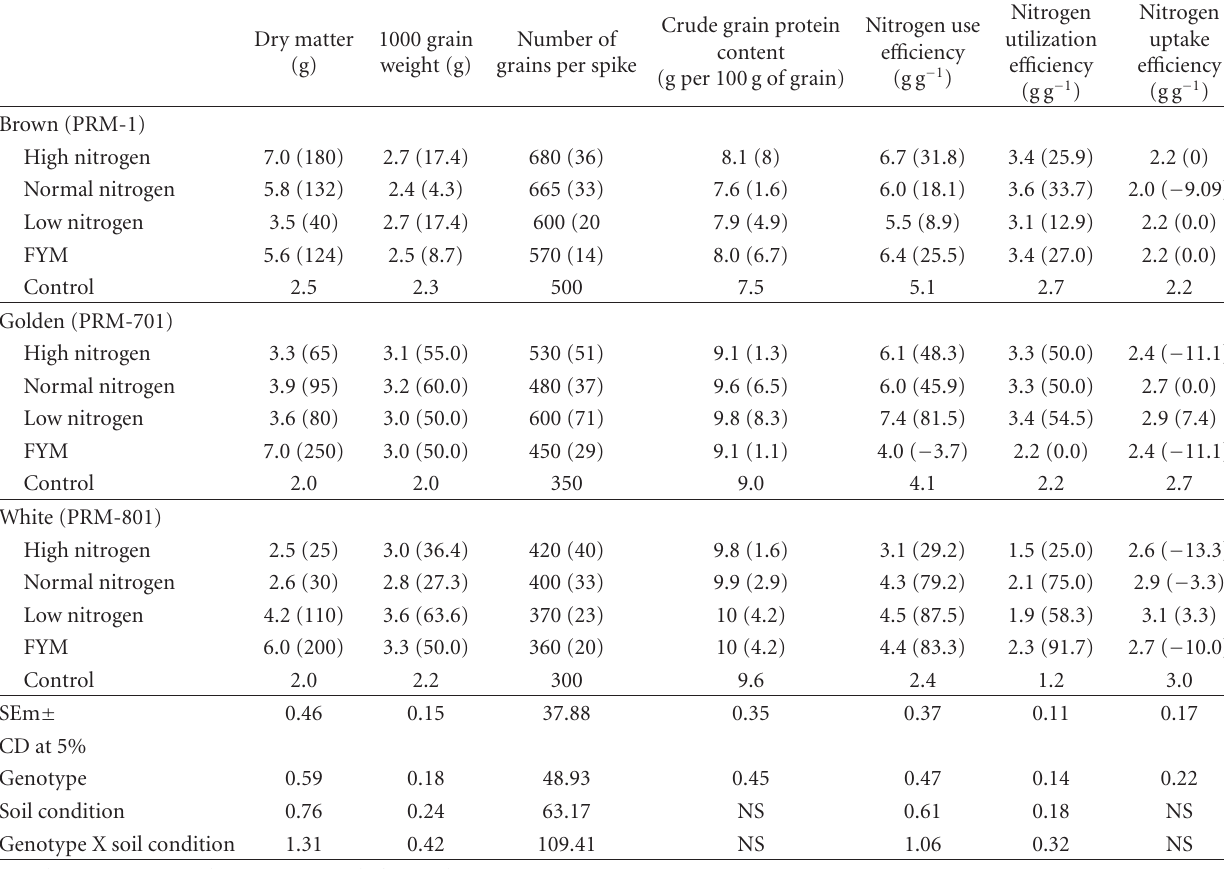
Table 2: Influence of genotype and soil condition on yield parameters.